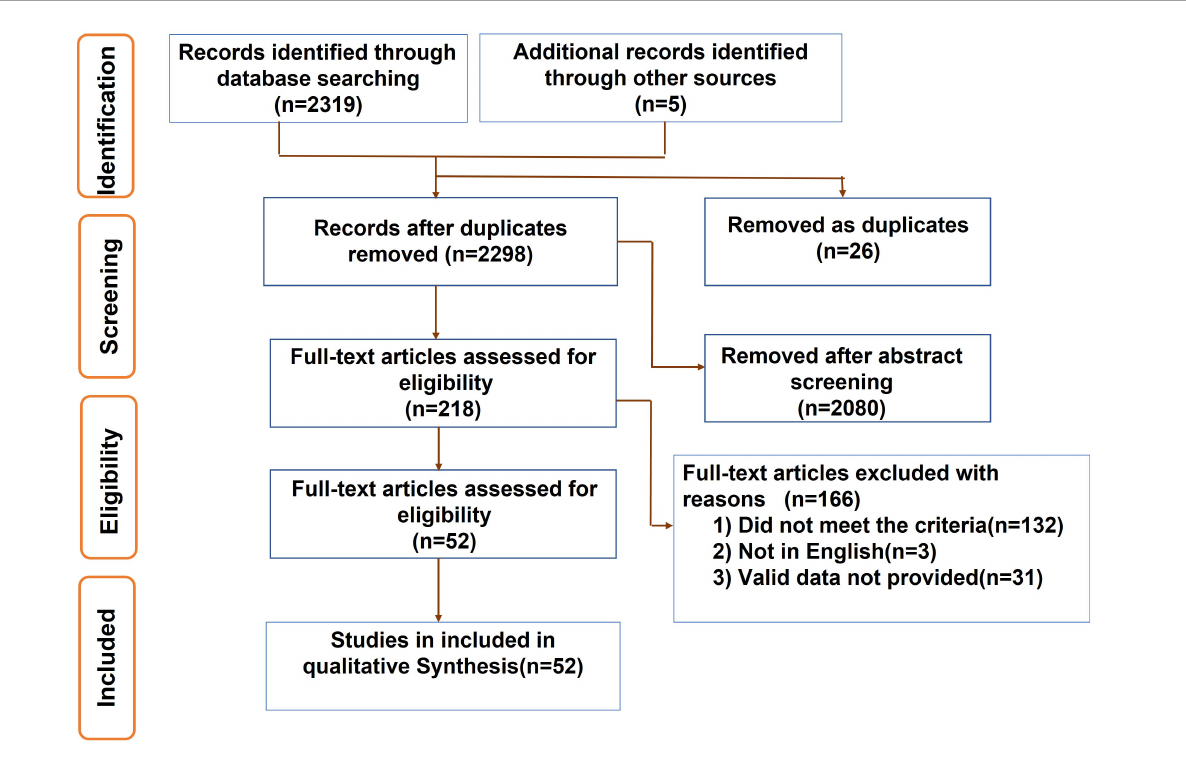
FIGURE1 Flow diagram showing the process of study identification and